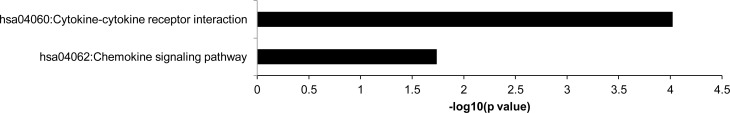
KEGG pathways enriched by INCA-6 treatment in HRMEC.Pathway enrichment was determined using DAVID and a p value < 0.05.